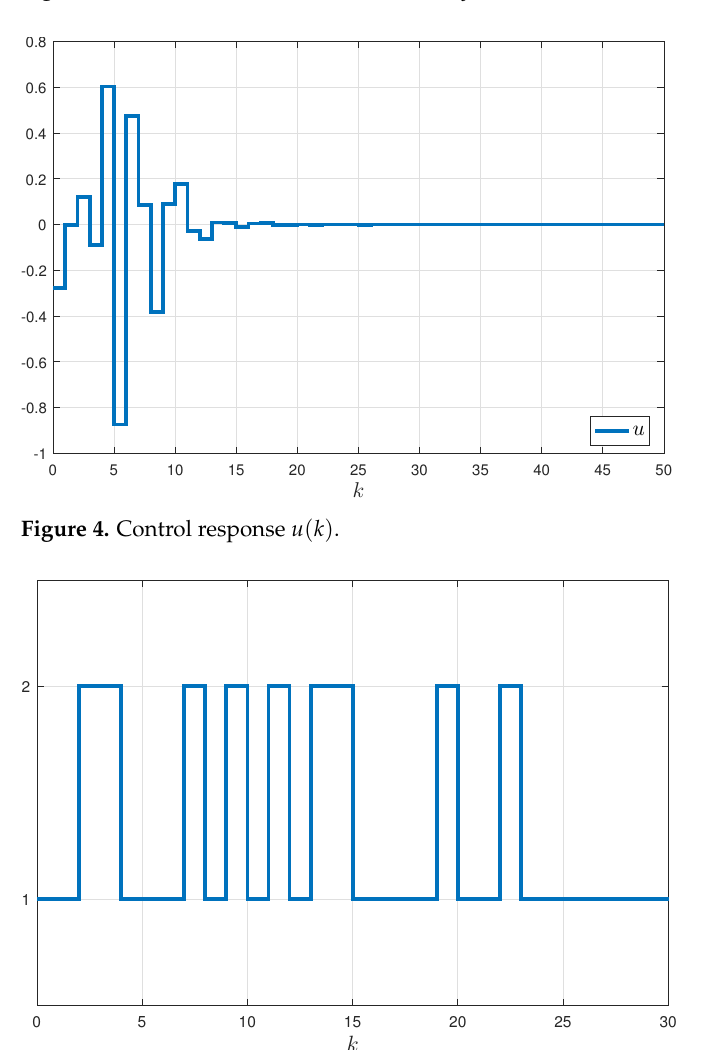
Figure 3. Actual and ideal measurements of y 3 .